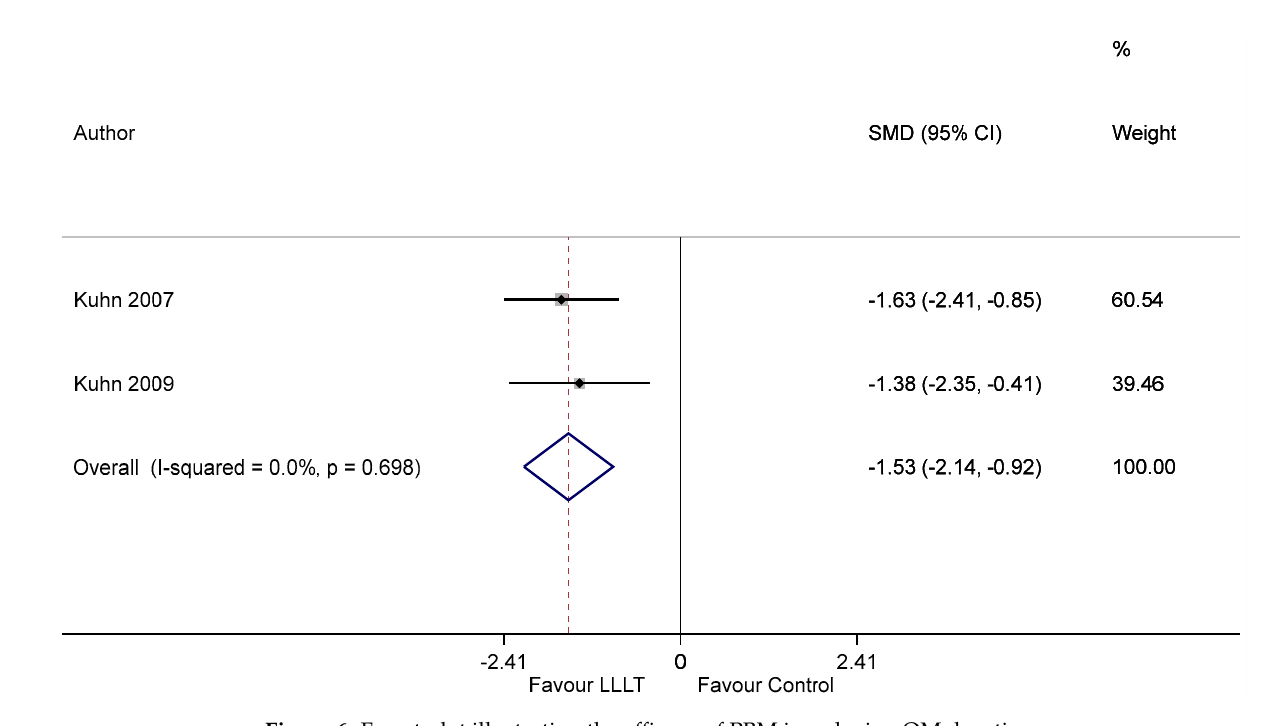
Figure 6. Forest plot illustrating the efficacy of PBM in reducing OM duration.